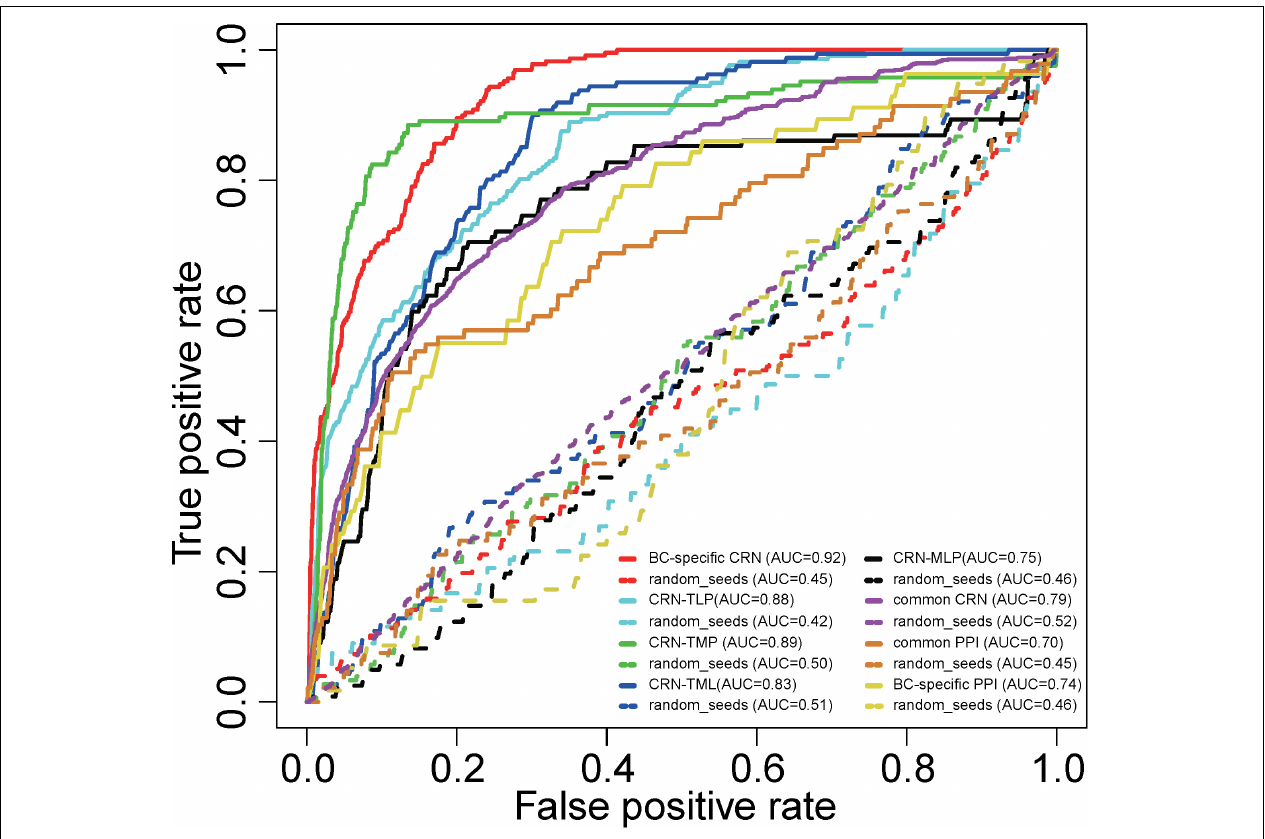
FIGURE 2 | Receiver operating characteristic curves and AUC values for the RWR method on the whole and partial BC-specific CRNs, common CRN, BC-specific PPI network, and common PPI network with real seeds and random